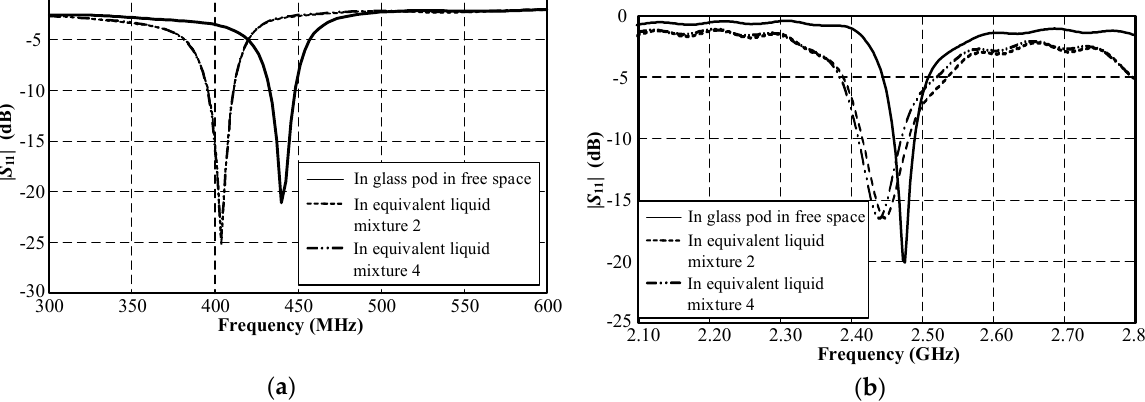
Figure 15. Measured | S 11 | of the MICS/ISM meander-line microstrip antenna encapsulated in a glass pod in free space and in equivalent liquid mixtures 2 and 4: ( a ) MICS and ( b ) ISM bands.